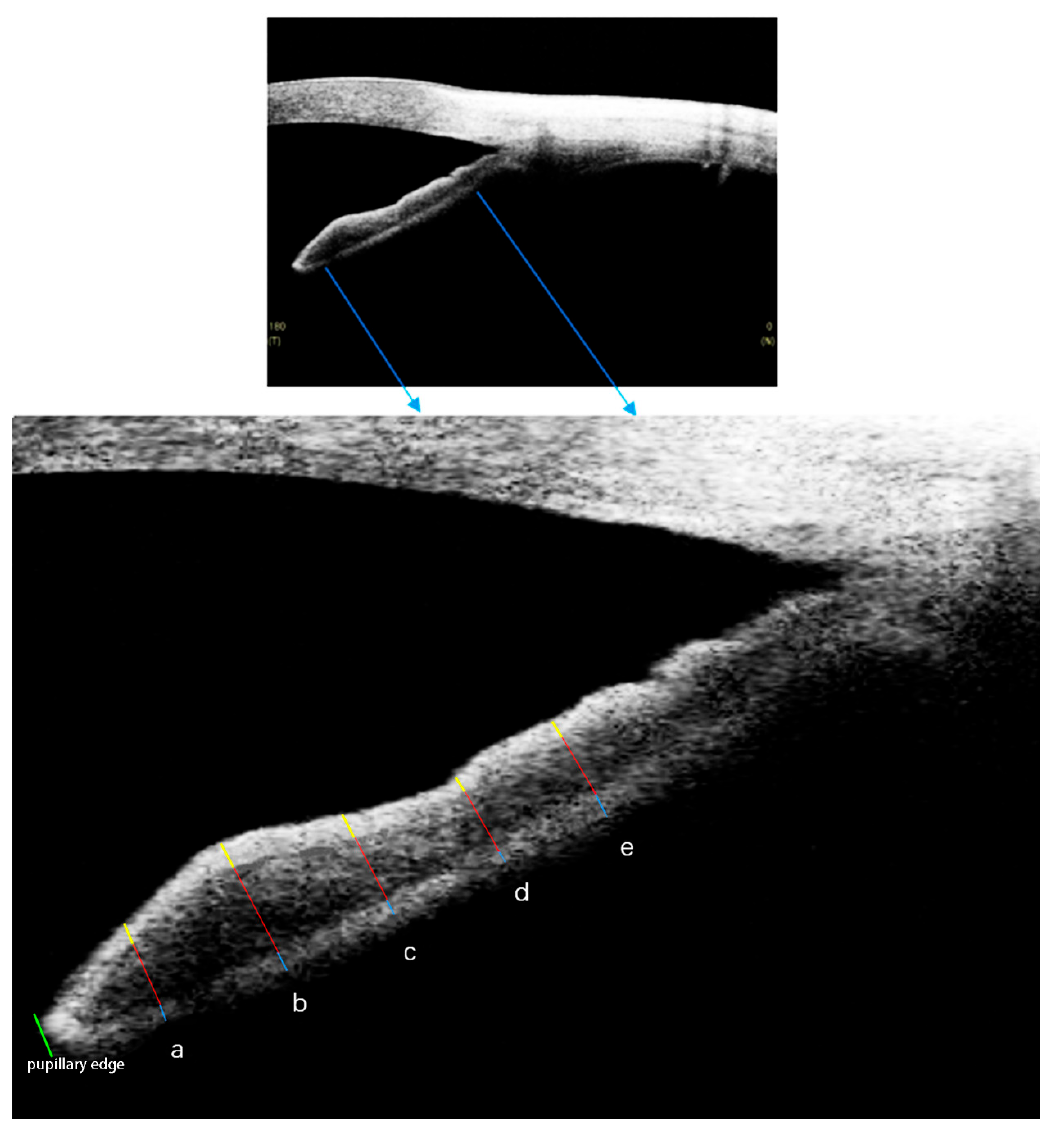
Figure 1. The measurements of iris thickness. The anterior border layer (yellow line) and posterior pigmented epithelial layer (blue line) of iris are seen as two separate narrow hyper-reflective bands. The middle stromal layer (red line) of iris is seen as a wide hypo-reflective band. The iris thickness was measured at 500 μ m (a), 1000 μ m (b), 1500 μ m (c), 2000 μ m (d), and 2500 μ m (e) from the pupillary edge (green line), respectively.